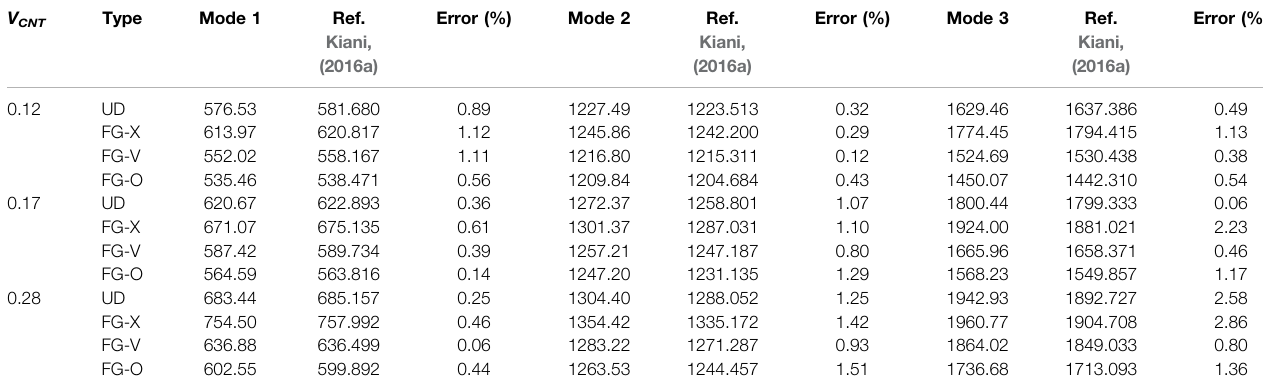
TABLE 4 | Effects of CNT volume fraction and distribution type on the fi rst three frequencies